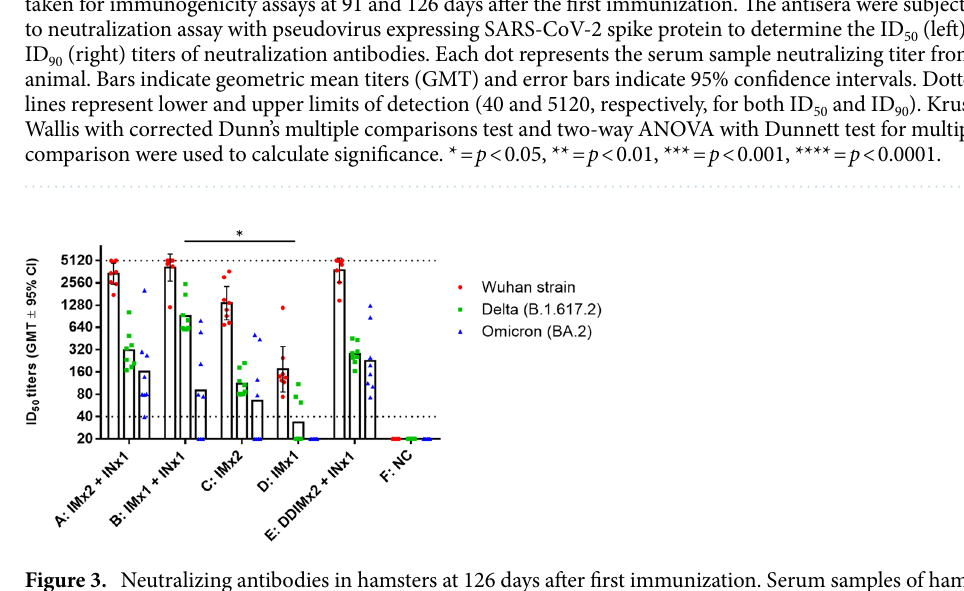
Figure 3. Neutralizing antibodies in hamsters at 126 days after first immunization. Serum samples of hamsters from Fig. 2 were taken at 126 days after the first immunization and subjected to neutralization assay with pseudoviruses expressing SARS-CoV-2 spike protein from the Wuhan strain, Delta, or Omicron variant. Each dot represents the serum sample neutralizing titer from each animal. Bars indicate geometric mean titers (GMT) and error bars indicate 95% confidence intervals. Dotted lines represent lower and upper limits of detection (40 and 5120, respectively, for ID 50 ). Kruskal–Wallis with corrected Dunn’s multiple comparisons test and two-way ANOVA with Dunnett test for multiple comparison were used to calculate significance. * = p < 0.05, ** = p < 0.01, *** = p < 0.001, **** = p <